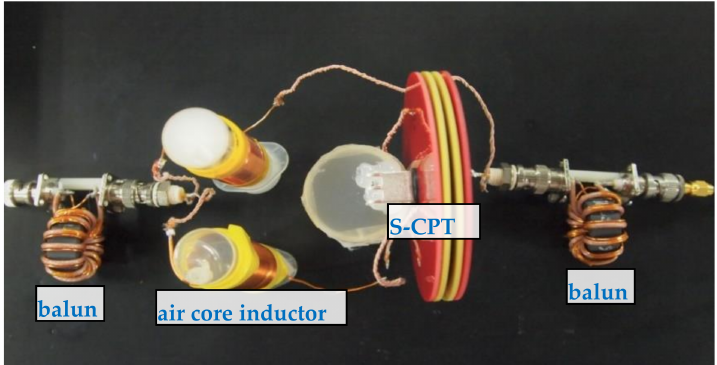
Figure 17. Experimental setup of the S-CPT system.